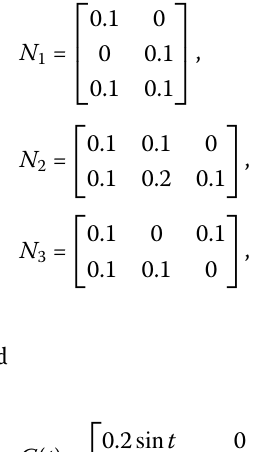
20 rand ( t ),2 sin (5 t ) + 18 rand ( t )] T where rand ( · ) represents the random function